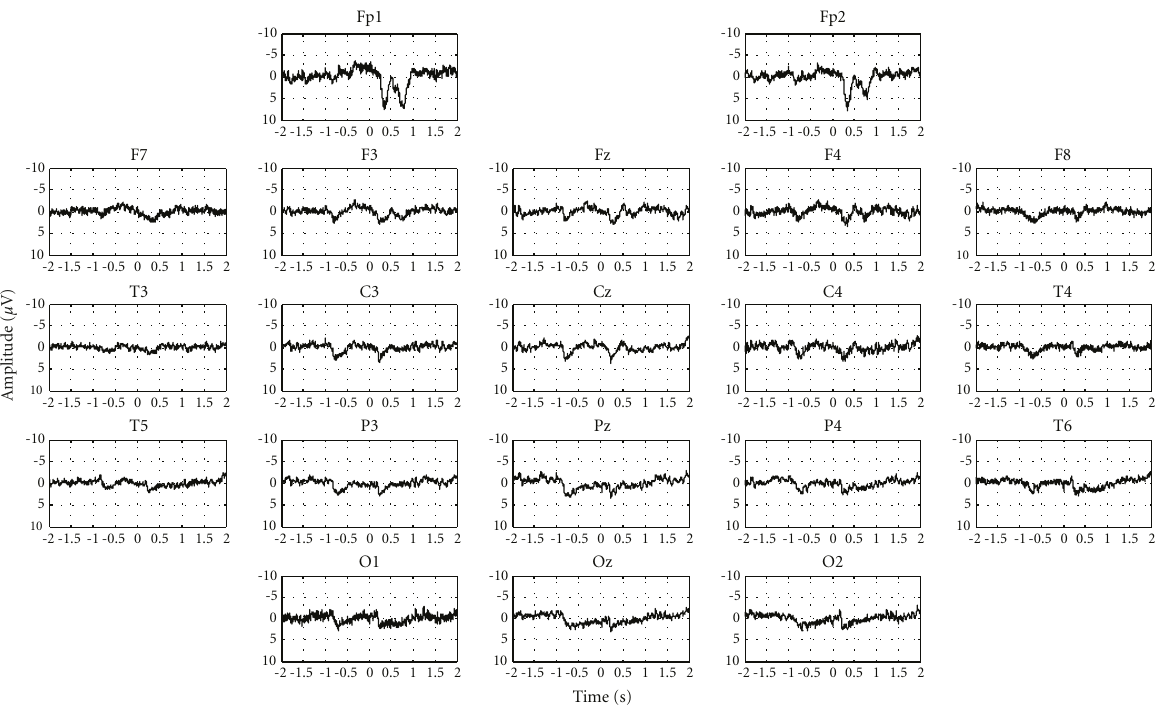
Figure 3: Grand Average topographic distribution of ERPs from spontaneous EEG, with lighted